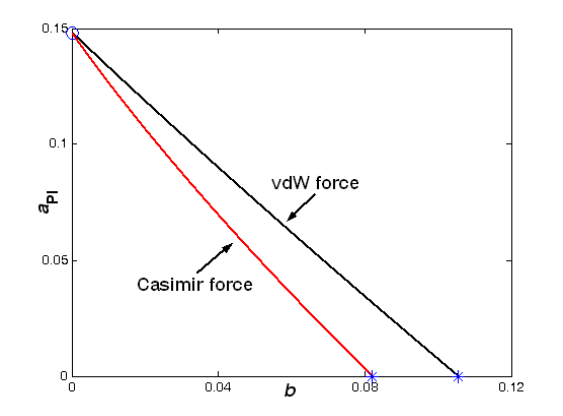
Figure 4 . Comparison between vdW and Casimir forces with variation of the pull-in a with parameter b parameter PI